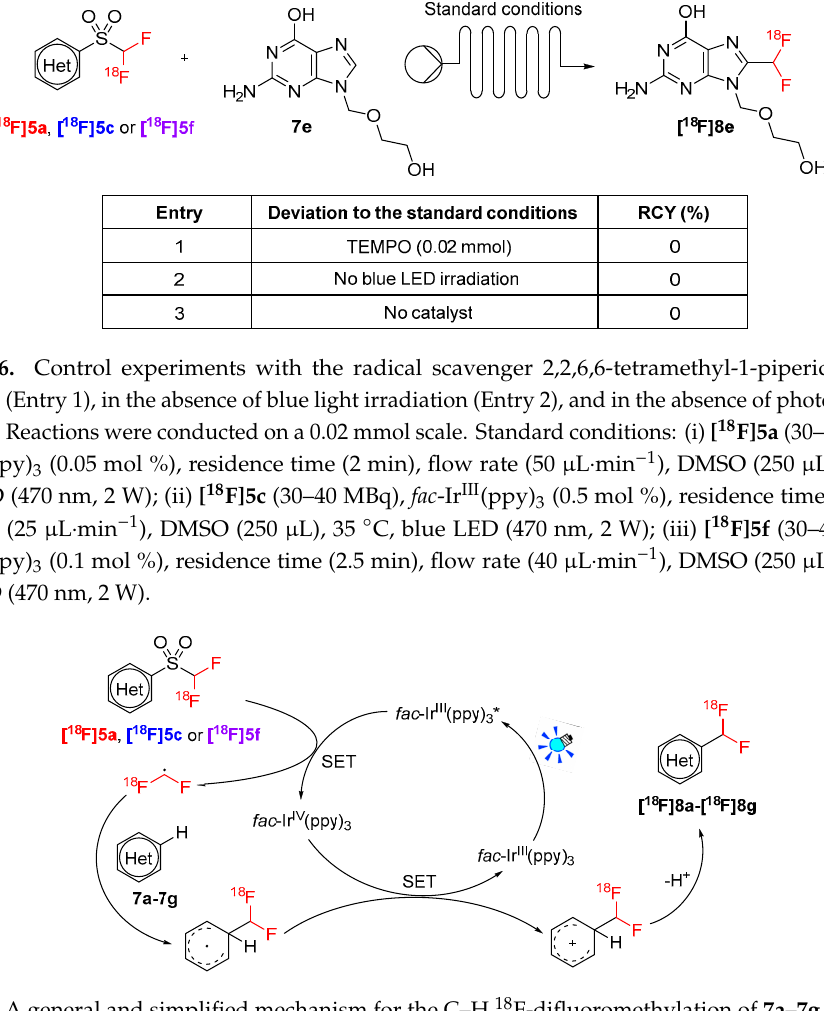
Figure 7. A general and simplified mechanism for the C–H 18 F-difluoromethylation of 7a – 7g with the sulfones [ 18 F]5a , [ 18 F]5c , and [ 18 F]5f .